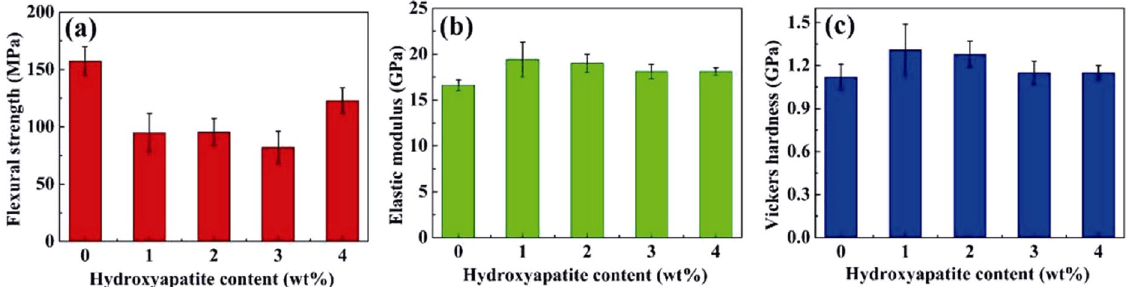
Fig. 3 Effect of hydroxyapatite addition on the mechanical properties of PICNs: (a) flexural strength, (b) elastic modulus, and (c) Vickers